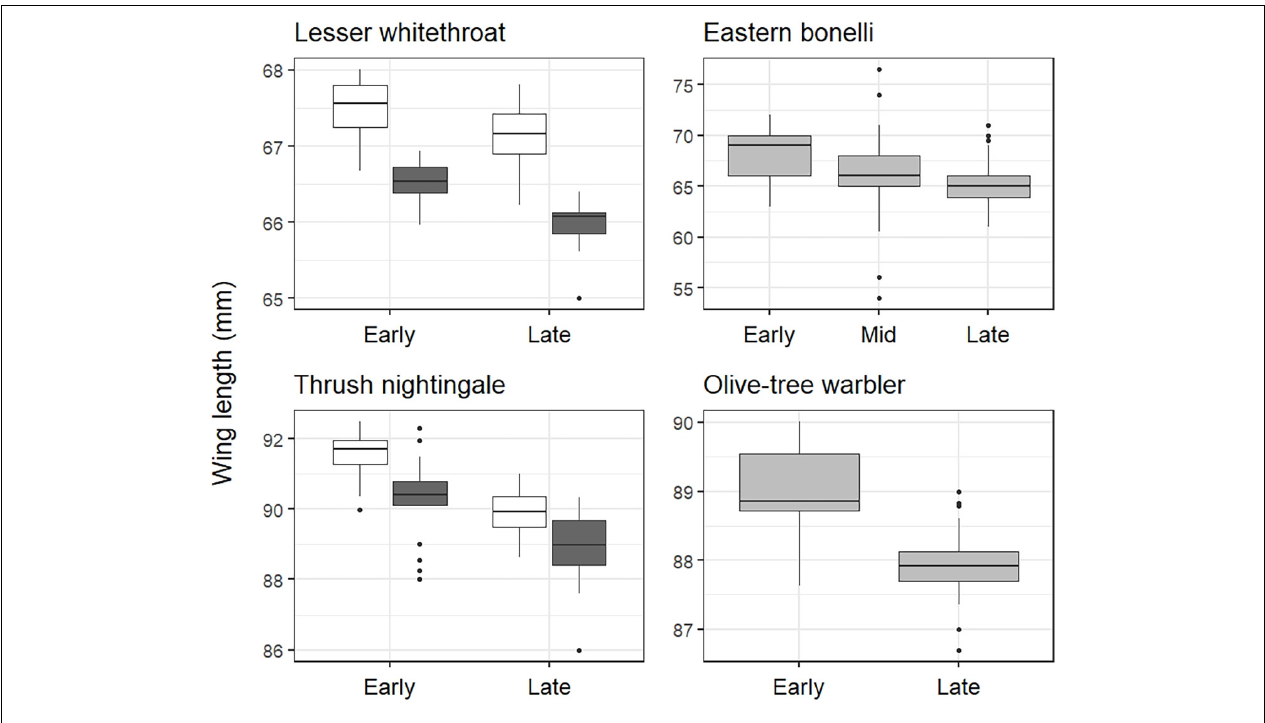
FIGURE 3 | Wing length differences between arrival phases in the four migratory passerines species caught at a stopover site in Israel during spring migration (2000–2021). Box-and-whisker describing the mean yearly wing length for each arrival group on the x-axis, and black stripes depict the median. Early and late arrivals were calculated as the first and last 30% of individuals on their first capture. For Lesser whitethroat and Thrush nightingale, data is separated into adults (white boxes) and second year individuals (dark grey boxes). Due to limited sample size ( Supplementary Table 1 ), data for Eastern Bonelli’s warbler were not divided into arrival phases, but the whole data set was used to analyse trends in wing length against arrival day. For the purpose of representation, boxes in this plot show mean wing length of the first and last 30% (“Early” and “Late”), as well as of the core arrivals (“Mid”). Statistical models are detailed in Table 2 .